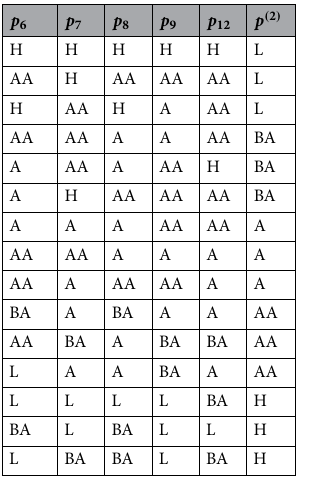
Table 3. Knowledge base according to equation p ( 2 ) = f p ( 1 )